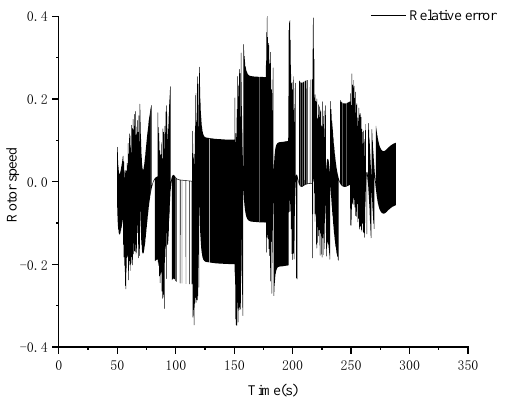
Figure 21. Relative error between the actual rotor speed and measured rotor speed.